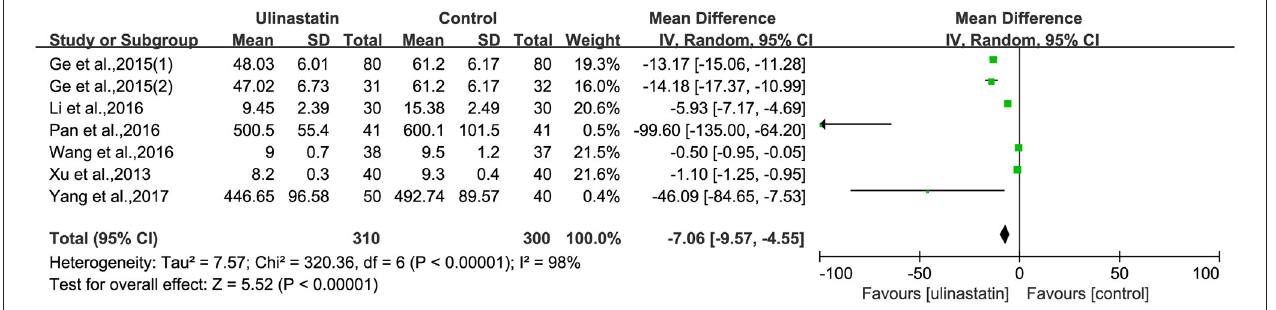
FIGURE 8 | Forest plot: Comparing plasma interleukin (IL)-6 of patients receiving ulinastatin vs. control.